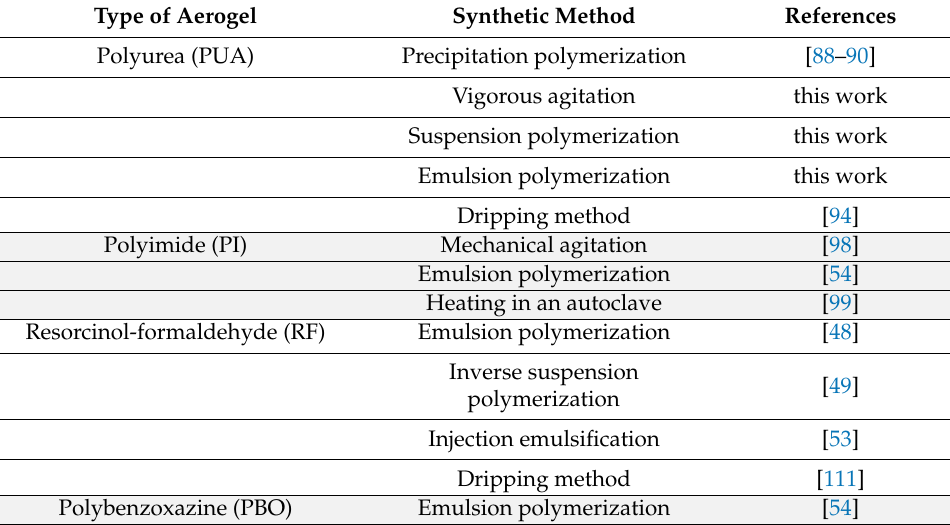
Table 3. Summary of the synthetic methods used for the preparation of aerogel particles from synthetic polymers reviewed in this work.